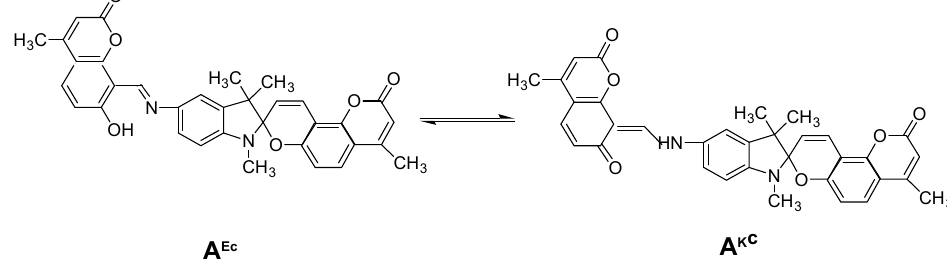
Scheme 12. Tautomeric equilibrium between the A Ec and A Kc forms of the hybrid compound 1 . Compound 1 demonstrates photochromic properties typical for spiropyrans (Scheme 13).